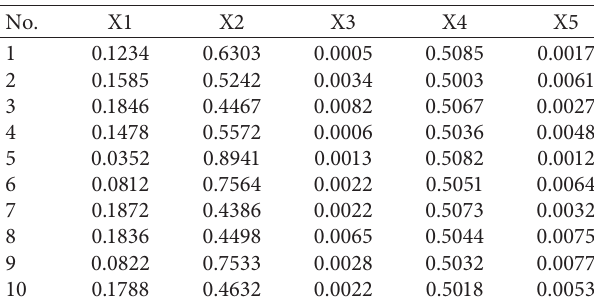
Table 4: Results of Example